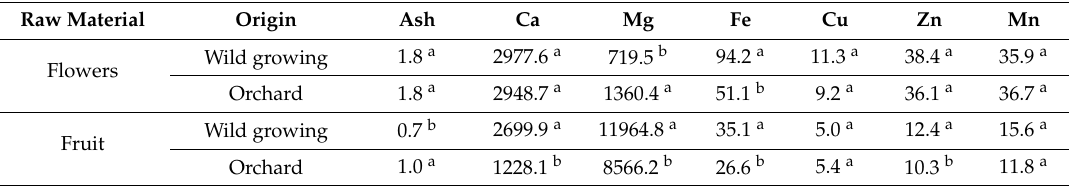
Table 2. The average content of ash (%) and selected minerals ( µ g / g d.m.) in elderberry flowers and fruit, depending on raw material